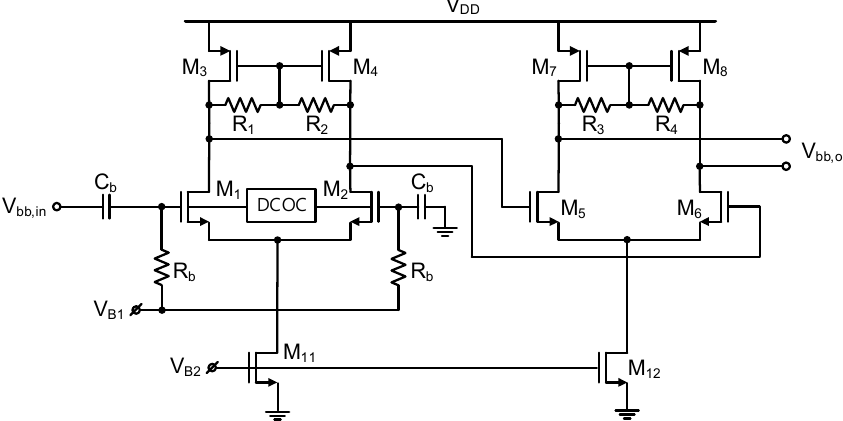
Figure 4. Baseband amplifier schematic.